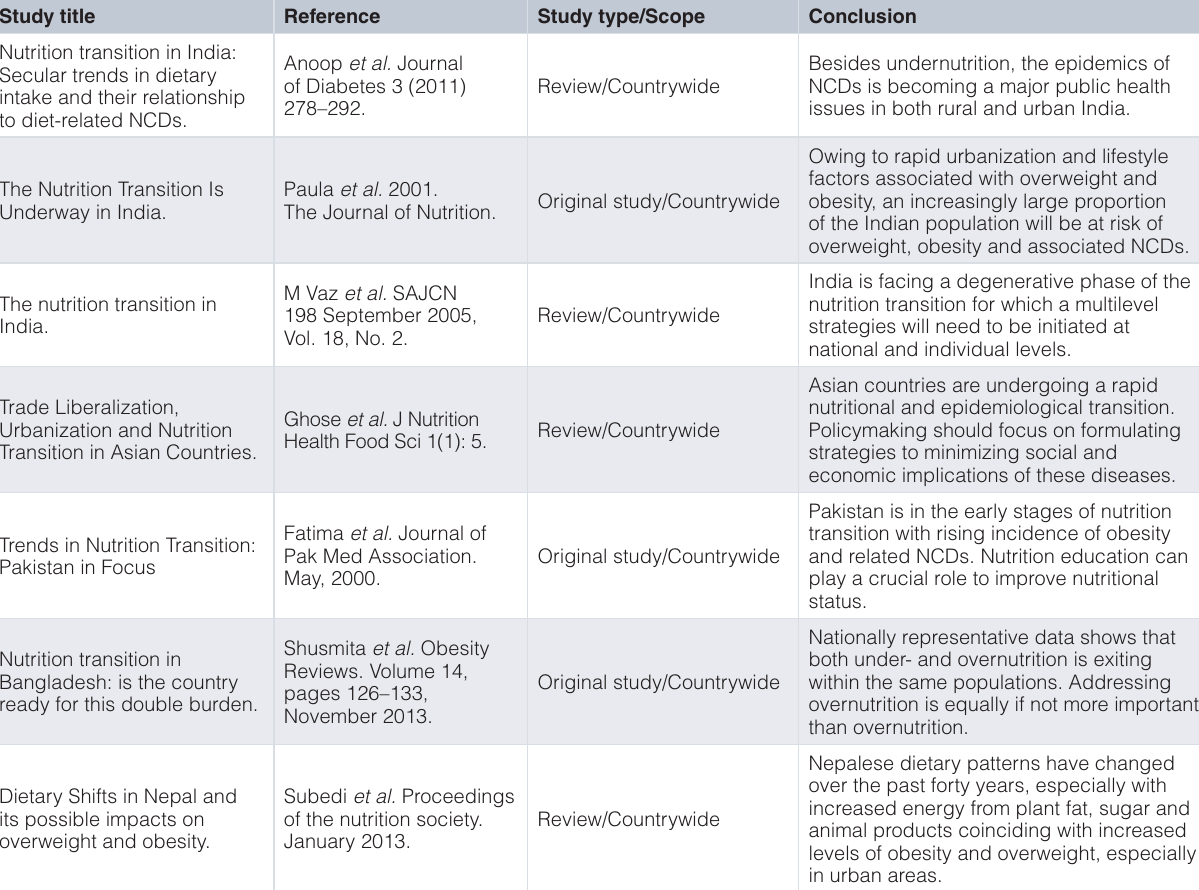
Table 4. List of selected studies on nutrition transition in South Asia and its impacts on nutrition